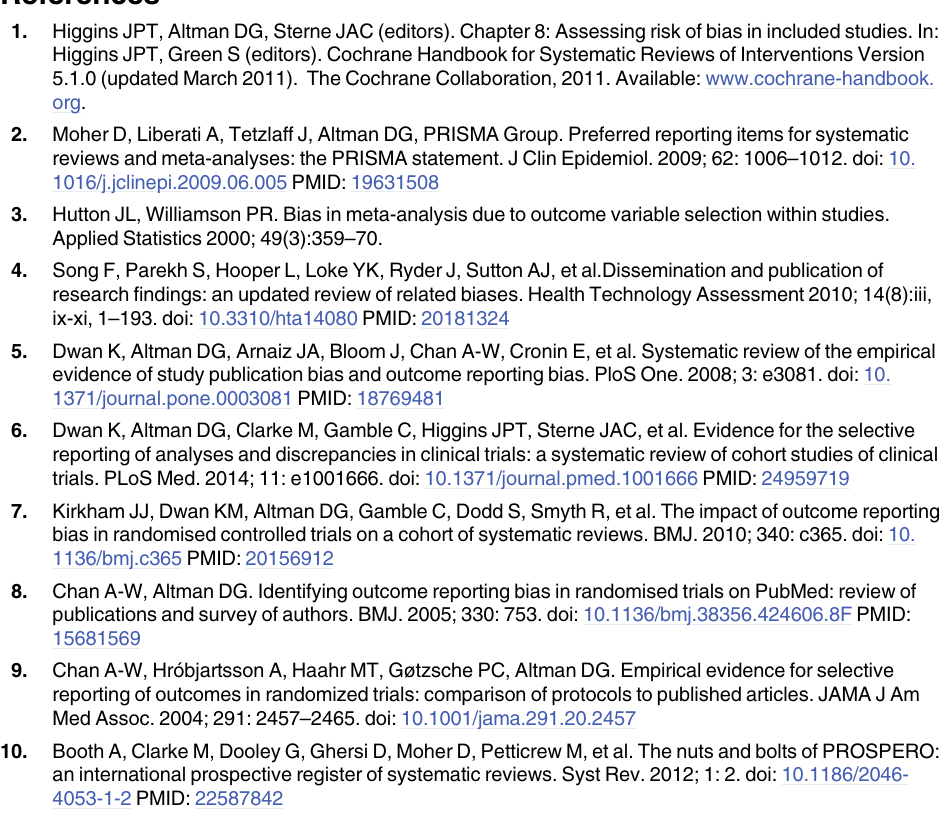
S1 Table. Distribution of discrepancies between protocols and reviews per subject area. S2 Table. Distribution of discrepancies between protocols and reviews per country of ori- gin. S3 Table. Explanation provided by authors for outcome changes between protocol and